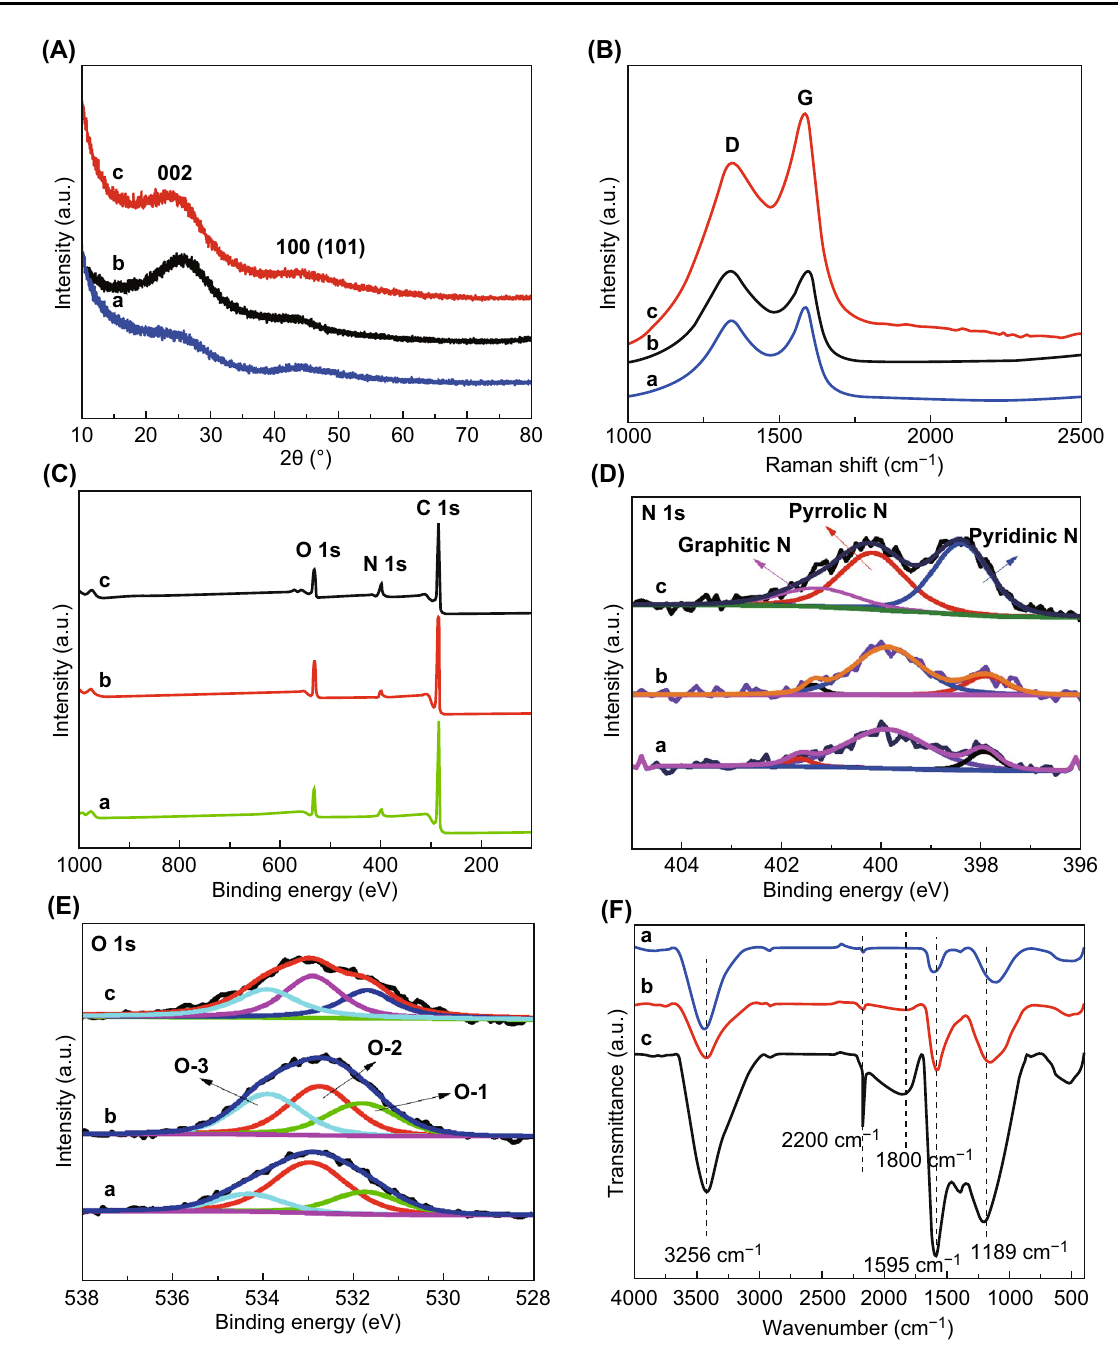
Fig. 3 A Wide-angle XRD patterns, B Raman spectra, C XPS survey spectra, D N 1 s XPS spectra, E O 1 s XPS spectra, and F FTIR spectra of HPNCF-2.0-900 (a), HPNCF-2.0-800 (b), and HPNCF-2.0-700